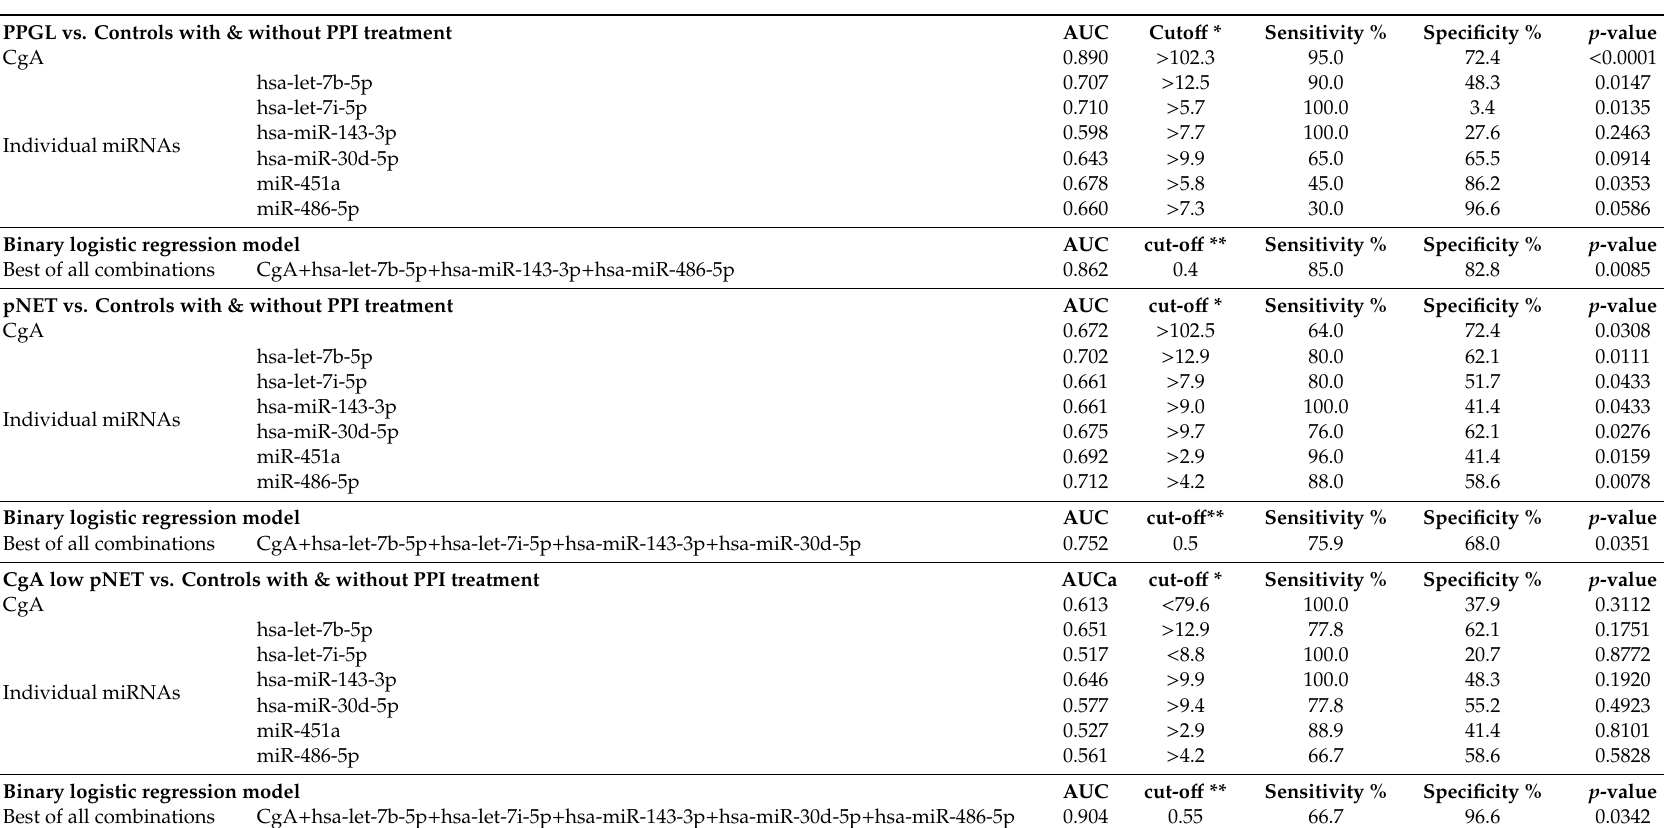
Table 3. Diagnostic performance of CgA, individual miRNAs, and the best combination of CgA with miRNAs between di ff erent groups. *: Cut o ff values of CgA in ng / mL and of miRNAs in dCt; **: Cut-o ff in binary logistic regression model. AUC: area under curve. PPGL vs. Controls with & without PPI